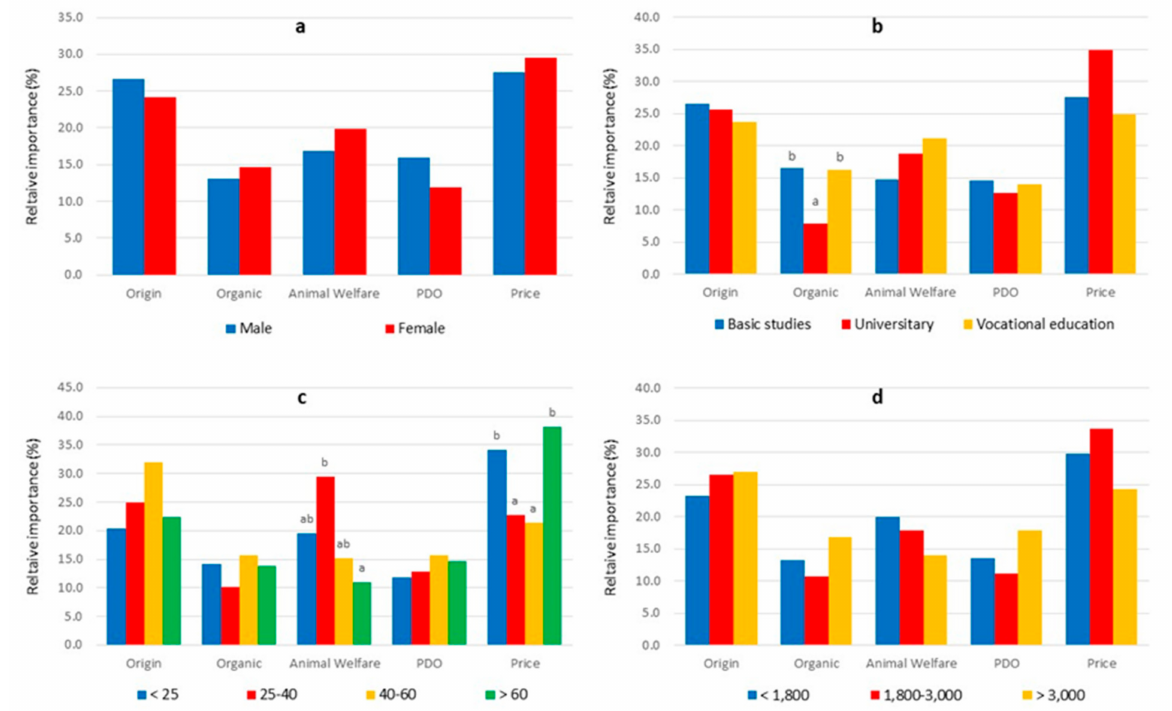
Figure 3. Relative importance (%) of the attributes for consumer segments according to gender ( a ), educational level ( b ), age ( c ), and income level ( d ). Means with different superscripts are statistically different ( p <